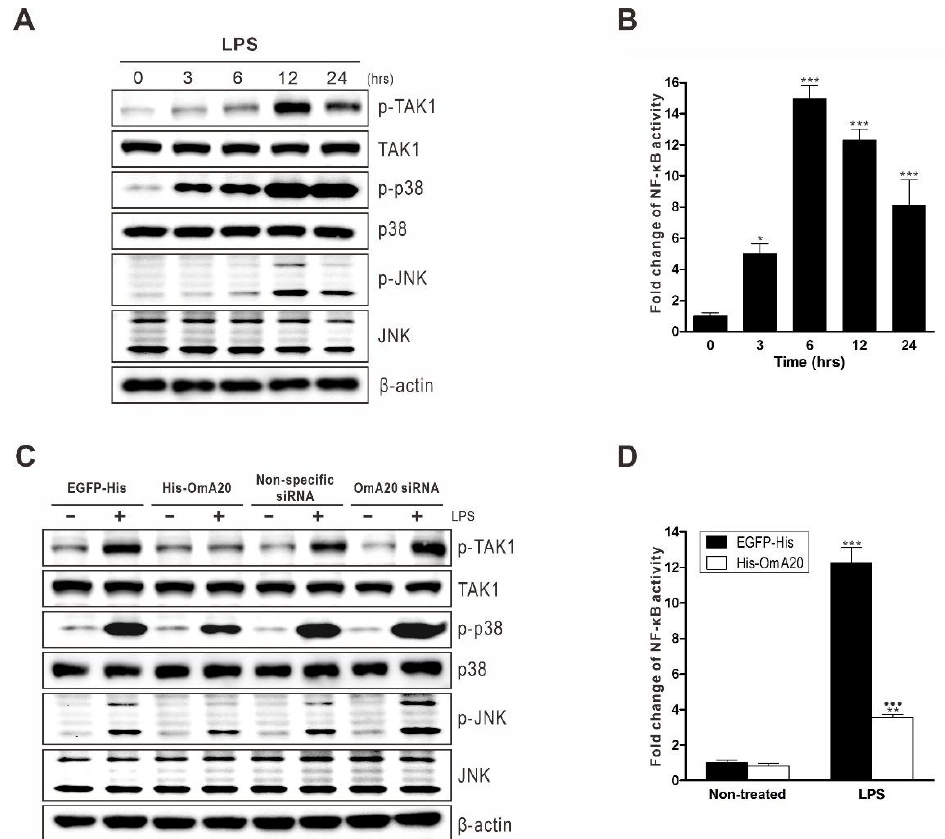
Figure 4. Involvement of OmA20 on MAPK and NF- κ B activation in RTH-149 cells stimulated with LPS. ( A ) After stimulating RTH-149 cells with LPS (10 µ g/mL) for the indicated time periods, phosphorylated, and total levels of TAK1, p38 MAPK, and JNK were determined by western blot analysis. ( B ) RTH-149 cells, co-transfected with pNF- κ B-Luc and pRL-TK for 48 h, were stimulated with LPS (10 µ g/mL) for the indicated time periods. Then, NF- κ B activity was determined using a dual-luciferase reporter assay system. ( C ) RTH-149 cells, transfected with His-OmA20, EGFP-His, OmA20 siRNA, or non-specific siRNA for 48 h, were stimulated with LPS (10 µ g/mL) for 12 h. Then, phosphorylated and total levels of TAK1, p38 MAPK, and JNK were determined by western blot analysis. ( D ) RTH-149 cells, co-transfected with a His-OmA20 or EGFP-His along with pNF- κ B-Luc and pRL-TK for 48 h, were stimulated with LPS (10 µ g/mL) for 12 h. Then, NF- κ B activity was determined using a dual-luciferase reporter assay system. * p < 0.05, ** p < 0.01, *** p < 0.001 unstimu-